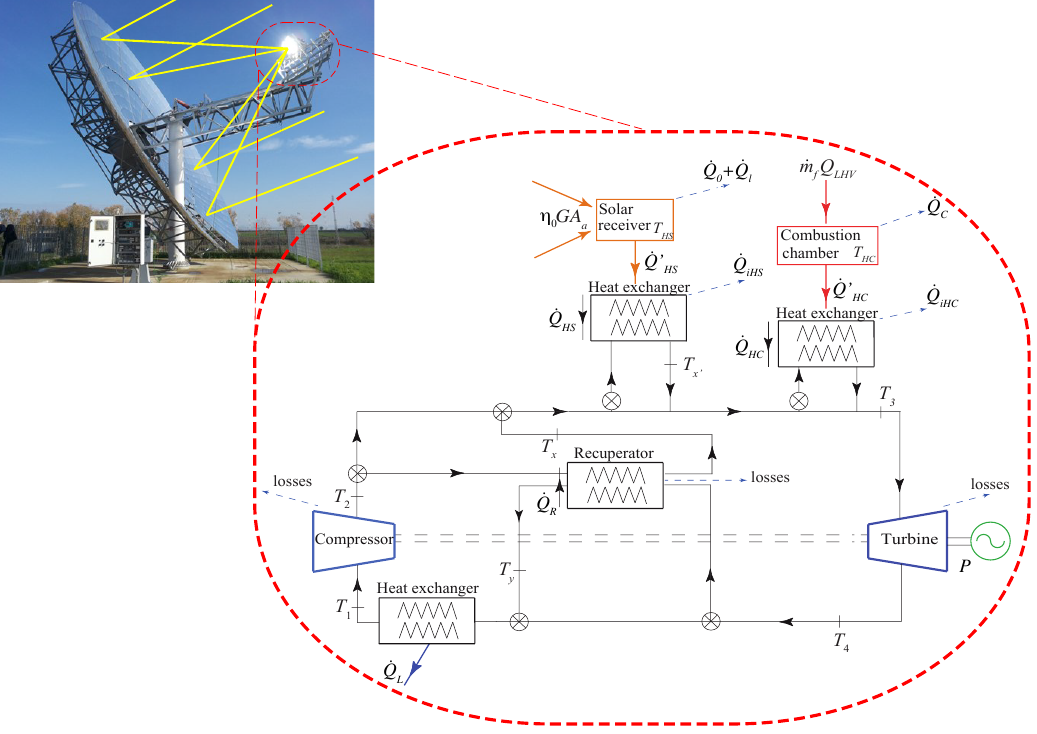
Figure 1. Schematic representation of the hybrid Concentrated Solar Power (CSP) plant composed of the parabolic dish collector and the Hybrid Solar Receiver Combustor (HSRC), which includes the solar receiver, the combustion chamber, and the micro-gas